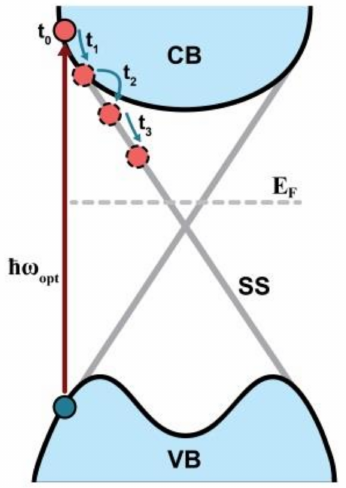
Figure 7. Relaxation of carriers in BSTS